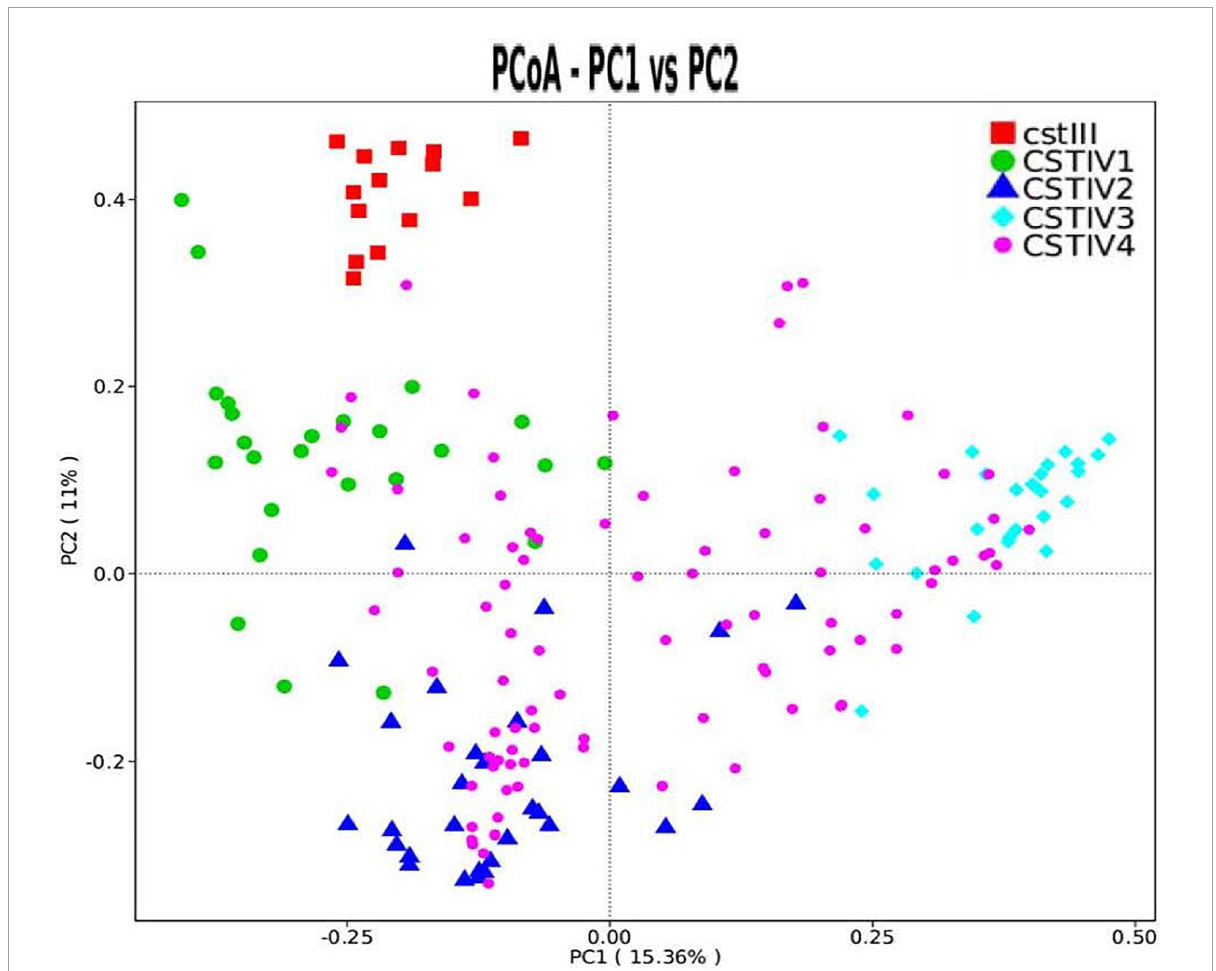
FIGURE3 PCoA dissimilarity in CST clusters. Principal coordinates analysis (PCoA) of microbial species data based on Bray–Curtis distance matric displayed the differences of samples between groups. Each dot represented a sample. Different shapes and colors represented corresponding